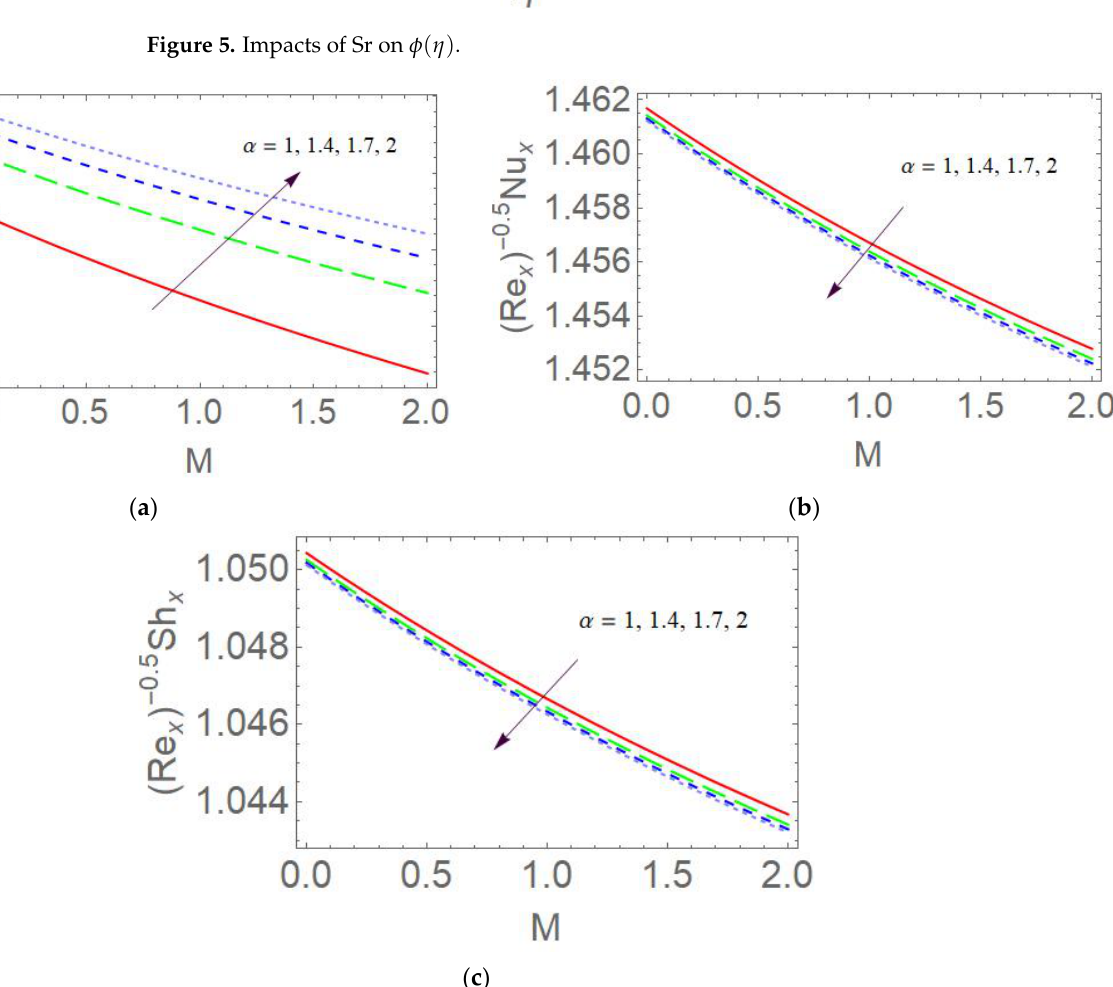
Figure 6. Influence of ( a ) α on C f ( Re x ) 0.5 , ( b ) α on Nu x ( Re x ) − 0.5 , and ( c ) α on Sh x ( Re x ) − 0.5